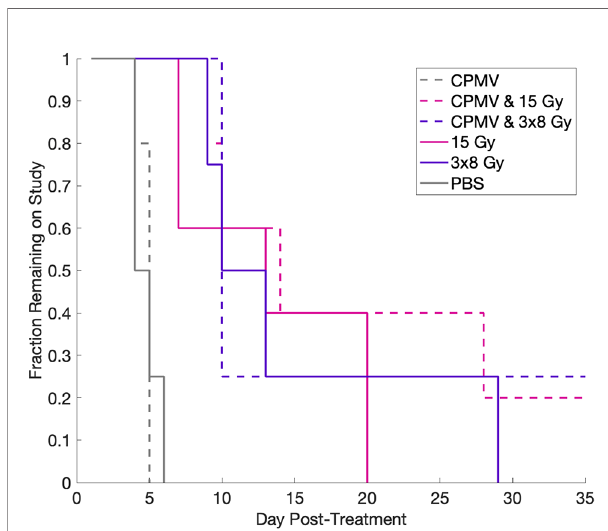
FIGURE 5 | Kaplan-Meier Curve. Kaplan-Meier curve demonstrating the changes in fraction on study for each treatment as a function of days post- treatment. Control and Cowpea mosaic virus (CPMV) cohorts lack separation, whereas all of the radiation cohorts are separated from control and CPMV, but not from each other. Using the log-rank (Mantel-Cox) test, we determined that treatment did signi fi cantly change survival, however, using multiple comparison adjustment and comparing two curves to each other, only control versus 15 Gy and control versus 15 Gy + CPMV were statistically signi fi cantly different.